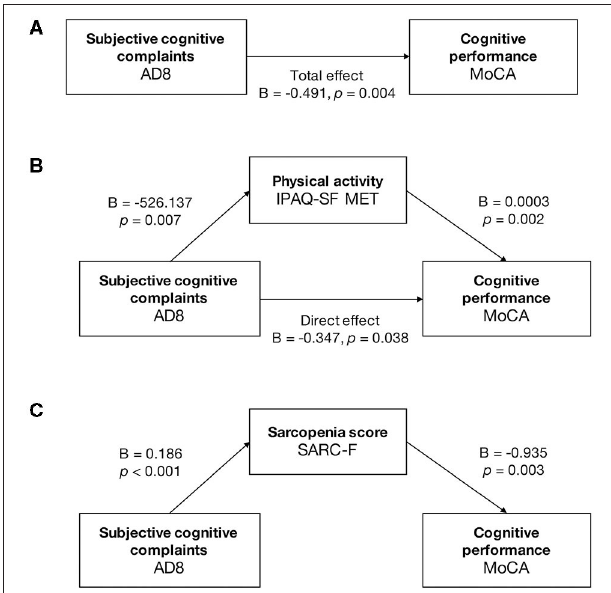
FIGURE 2 | Mediation analysis in cognitively normal older adults. Mediation analysis was run on the PROCESS model 4, with a level of confidence for all confidence intervals of 95.0000 and 5,000 bootstrap samples for percentile bootstrap confidence intervals. (A) The total effect between the AD8 and MoCA score was negative and significant (B = − 0.491, p = 0.004). (B) The IPAQ-SF MET partially mediated between the AD8 and the MoCA. The AD8 score caused the MoCA score directly (direct effect: B = − 0.347, 95% CI − 0.673 to − 0.021, p = 0.038) and partially through the IPAQ-SF MET (indirect effect: B = − 0.144, 95% CI − 0.291 to − 0.043). (C) The SARC-F had full mediation effects between the scores of AD8 and MoCA, with significant